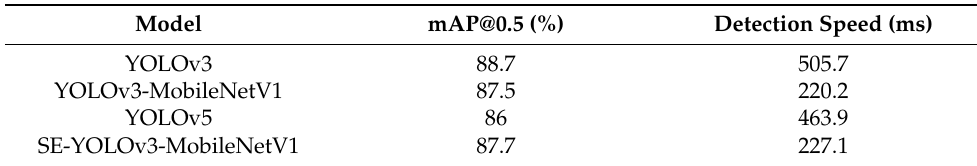
Table 3. Performance of the six models on the test